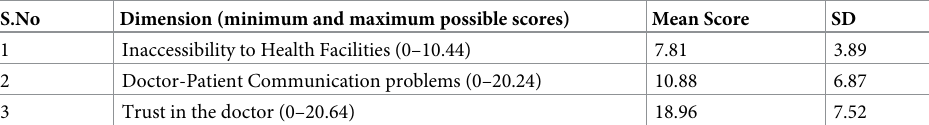
Table 4. Weighted scores on the dimensions of accessibility, communication and